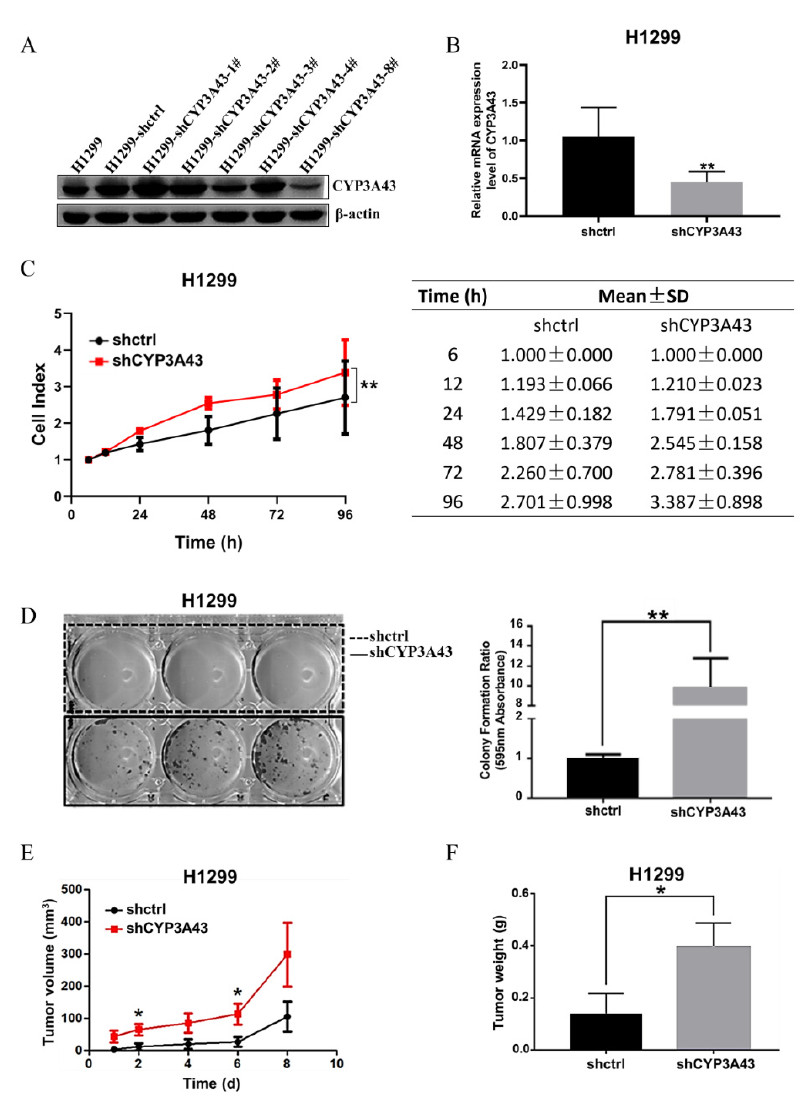
Figure 2. CYP3A43 knockdown facilitated the growth of H1299 cells both in vitro and in vivo. ( A ) The immunoblot results showed that CYP3A43 expression was suppressed by CYP3A43 shRNA, and H1299-shCYP3A43-8# had the strongest inhibitory effect. ( B ) The mRNA level of stable CYP3A43-knockdown H1299 cells and the shctrl cells was detected by RT-PCR analysis. ( C ) Real-time monitoring of CYP3A43 on the proliferation of H1299-shctrl and H1299-shCYP3A43 cells were confirmed by RTCA. The results are shown as the mean ± SD, n = 3. ( D ) Knockdown of CYP3A43 in H1299 cells significantly promoted colony formation ability compared to the shctrl cells. ( E , F ) Stable CYP3A43 knockdown in H1299 cells increased tumor growth ( E ) and tumor weight ( F ) ( n = 10 mice for each injected group). *, p < 0.05; **, p < 0.01.